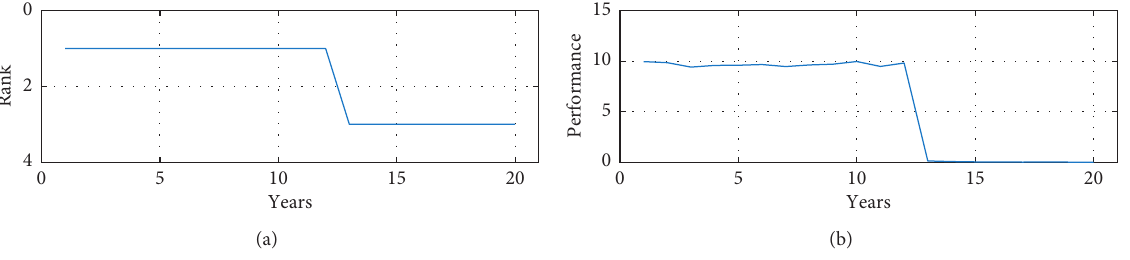
Figure 5: Rank history (a) and performance (b) of agent 103. During the simulation the employee 103 worsens his/her rank.